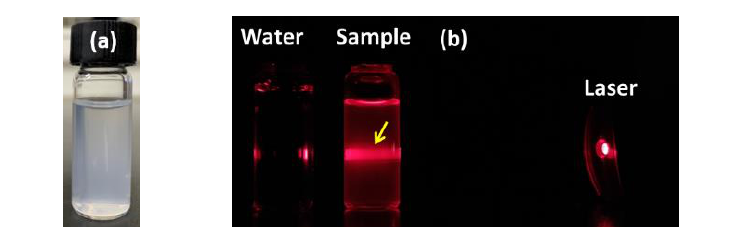
Figure 3. ( a ) Photograph of an aqueous solution of PASA-coated Gd 2 O 3 nanoparticles. ( b ) Laser scattering (or Tyndall effect) (indicated using an arrow) due to collisions between laser light and nanoparticle colloids in solution whereas no such laser scattering was observed in triple-distilled water. ( c ) Zeta potential curve.